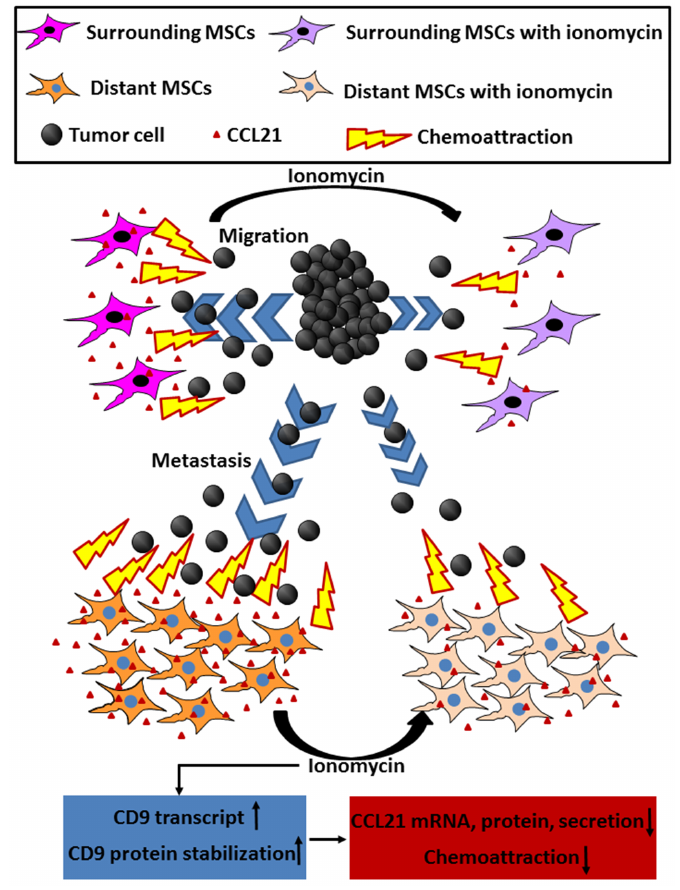
Figure 9. Schematic illustration of the role of the CD9-CCL21 axis pathway in regulating cancer cell migration/metastasis. CCL21 holds chemoattraction to cancer cells for migration and metastasis. Ionomycin is supposed to upregulate MSCs’ CD9 via increasing CD9 transcription as well as protein stabilization, to result in decreasing the CCL21 mRNA, protein and secretion, and the consequent lower chemoattraction.